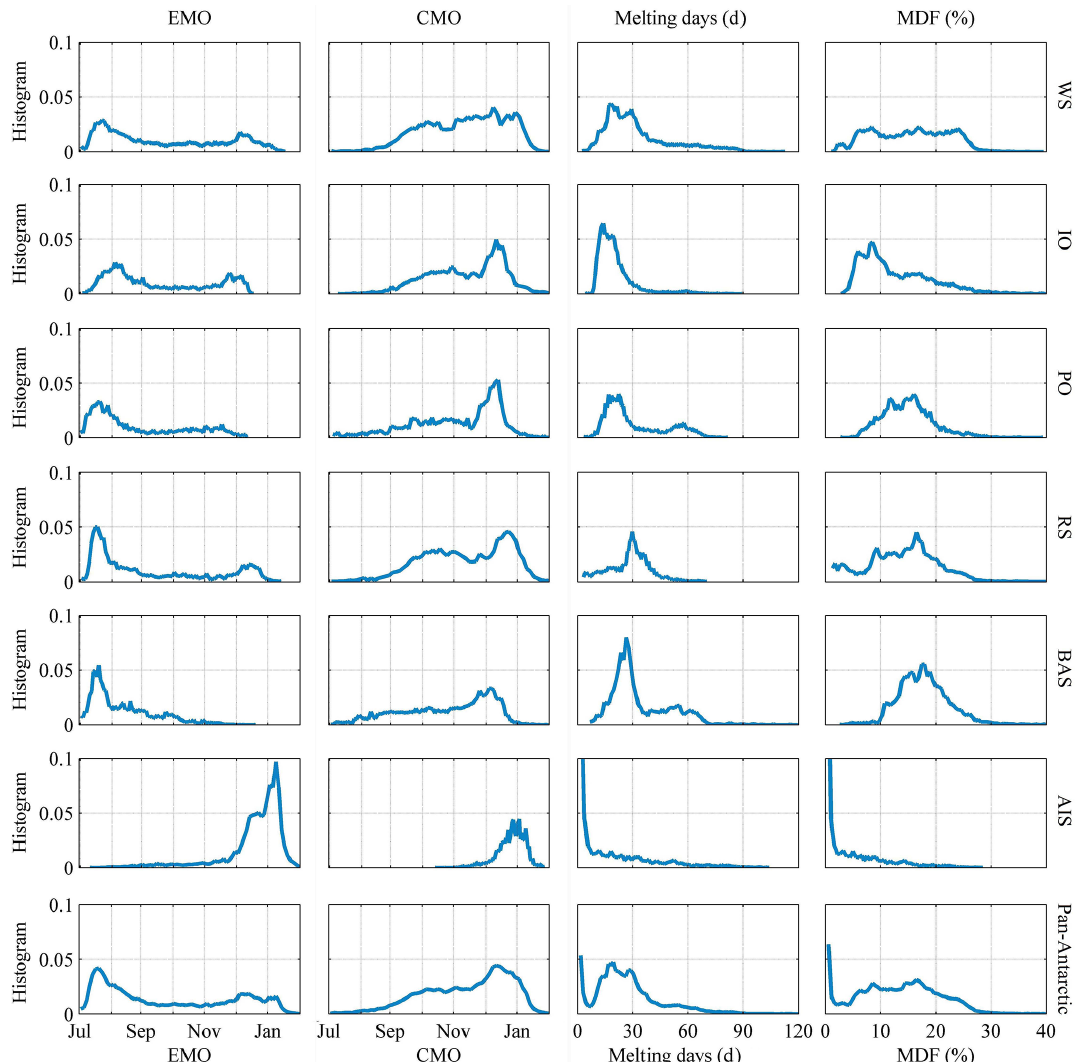
Figure 5. Normalized histograms of annual mean EMO, CMO, melting days and MDF for the pan-Antarctic region and different regions.